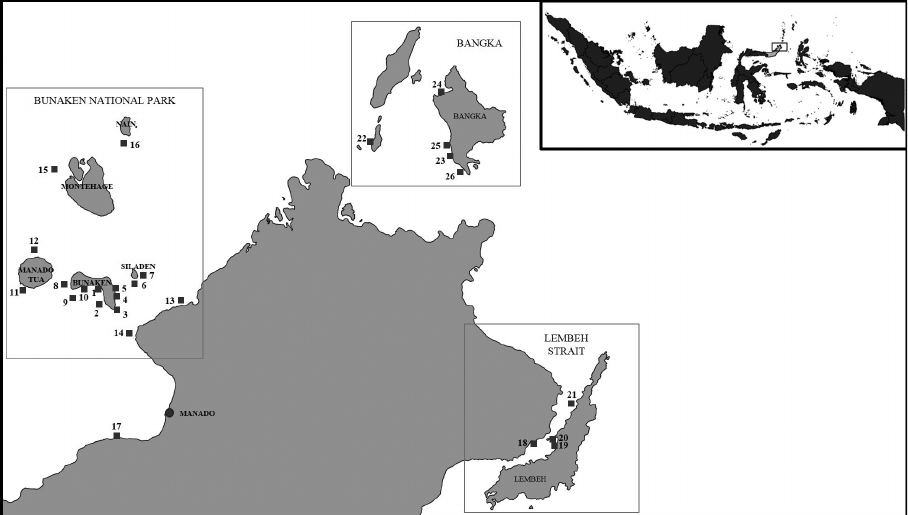
Figure 1. Locality map of North Sulawesi area showing the sponge collection sites. Black squares are the sampling sites. Key: 1 Liang 2 Lekuan II 3 Depan Kampung 4 Pangalisan 5 Timur 6 Siladen